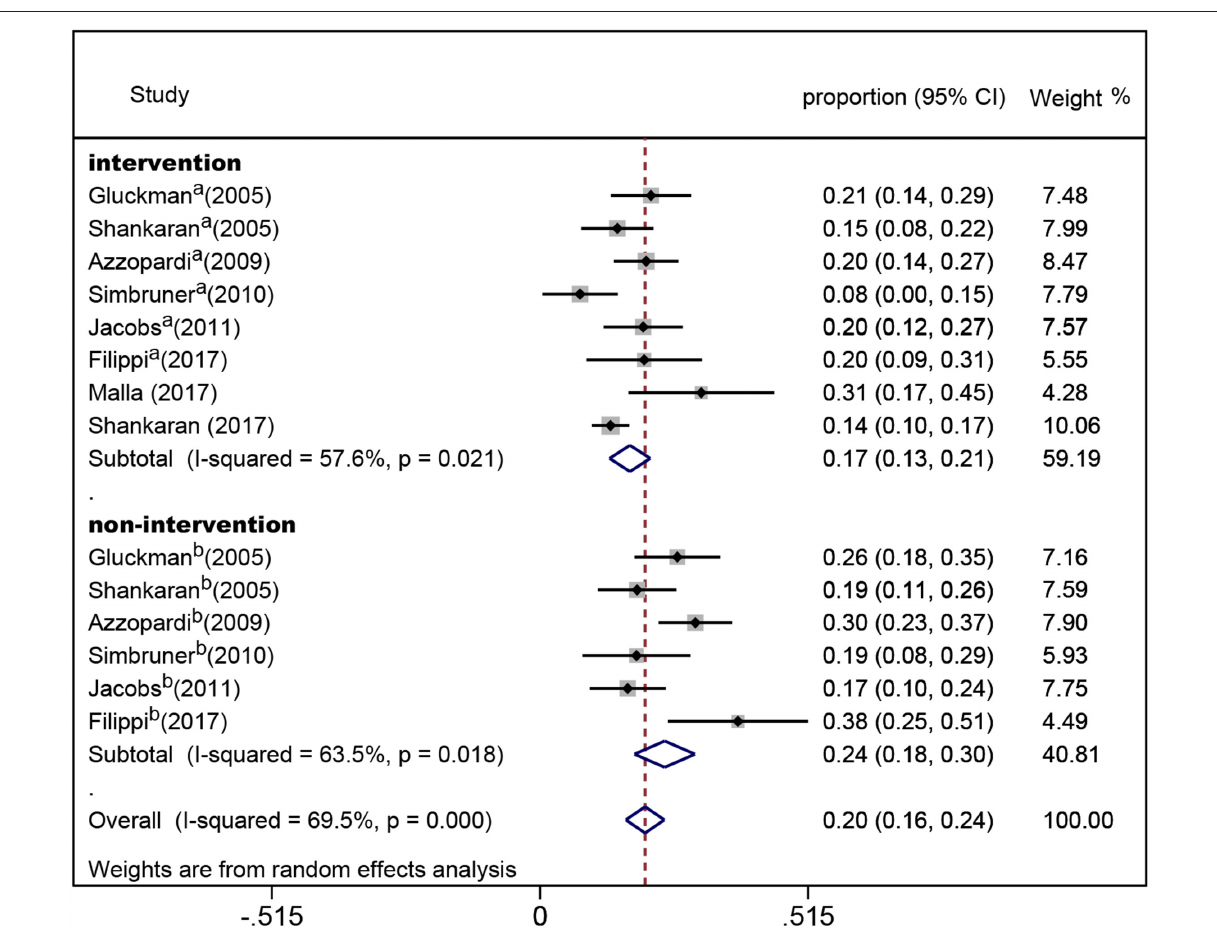
FIGURE 3 | Forest plot of the pooled rate of cerebral palsy in the intervention and non-intervention groups in randomized controlled trials. The solid diamonds and horizontal solid lines represent the proportions and 95% CIs of each included study. The size of the gray area indicates the study-specific statistical weight. The hollow diamonds show the pooled proportions and 95% CIs of each subgroup and the overall population. The vertical red dotted line shows the combined effect